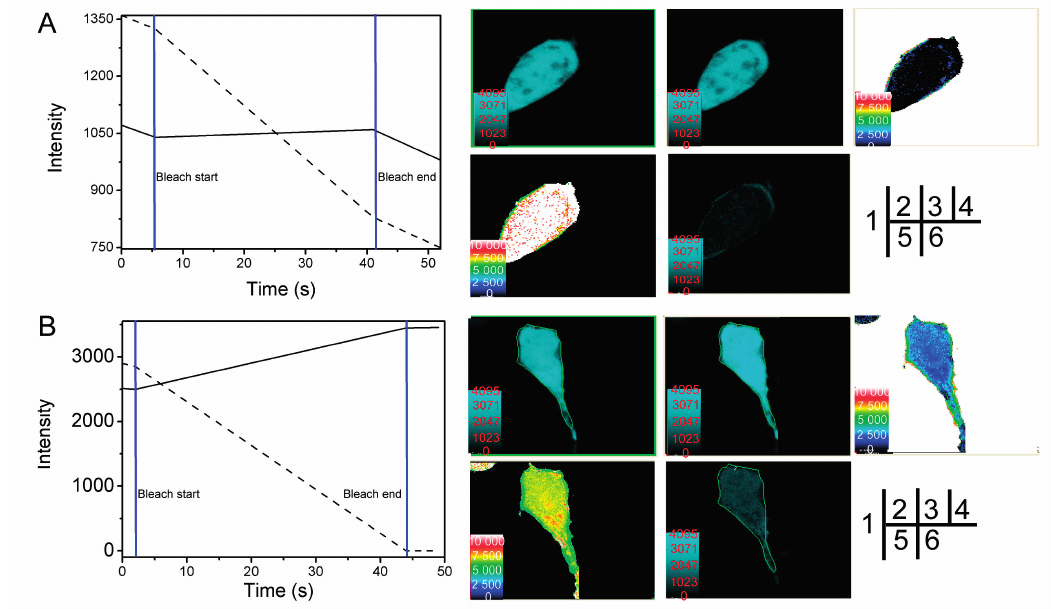
Figure 5. Verification of SelP-H and Tub-C interaction by the receptor photobleaching method of FRET. HEK293T cells were co-transfected with the empty plasmids pECFP-C1 and pEYFP-C1 as a negative control ( A ) or co-transfected with pECFP-C1- selp-h and pEYFP-C1- tub-c for sample tests ( B ). (1) Photobleaching curves (solid lines for donor fluorescence and dashed lines for receptor fluorescence). The region of interest (ROI) was bleached at 515 nm; (2) The fluorescence images of donors before bleaching; (3) The fluorescence images of donors after bleaching; (4) Donor fluorescence increments before and after bleaching; (5) Diagram of the distance between donor and receptor; (6) FRET efficiency